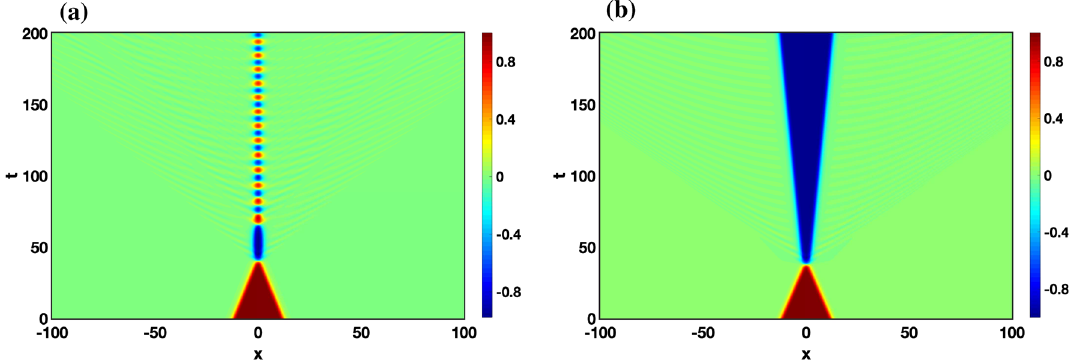
Fig. 6 Kink-antikink collisions for n = 1 with a v = 0 . 28 – bion and b v = 0 . 30 –